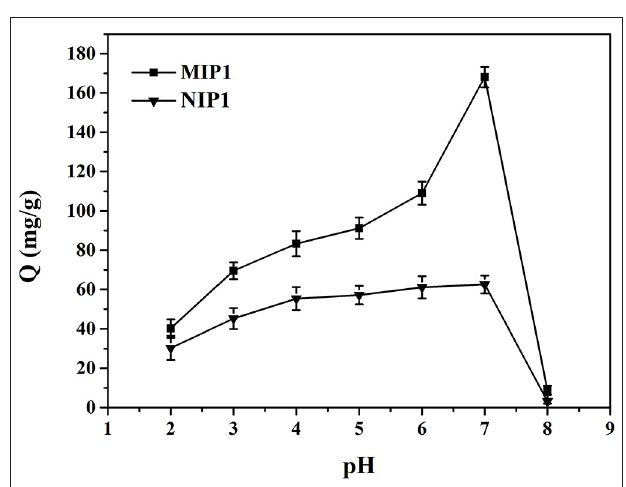
FIGURE 5 | The effect of pH on the adsorption experiments of MIP1 and NIP1 for ACT. monomers. Hydrogen bonds can be formed between different functional groups of monomers and hydroxyl groups of the template molecules in MIPs (Hammam et al., 2018; Panjan et